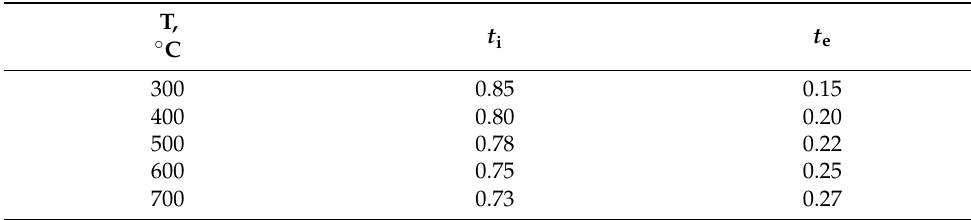
Table 3. Characteristics of mixed electrical conductivity for (CeO 2 ) 0.90 (Sm 2 O 3 ) 0.10 sample: transfer numbers of ions (t i ) and electrons (t e ) at different